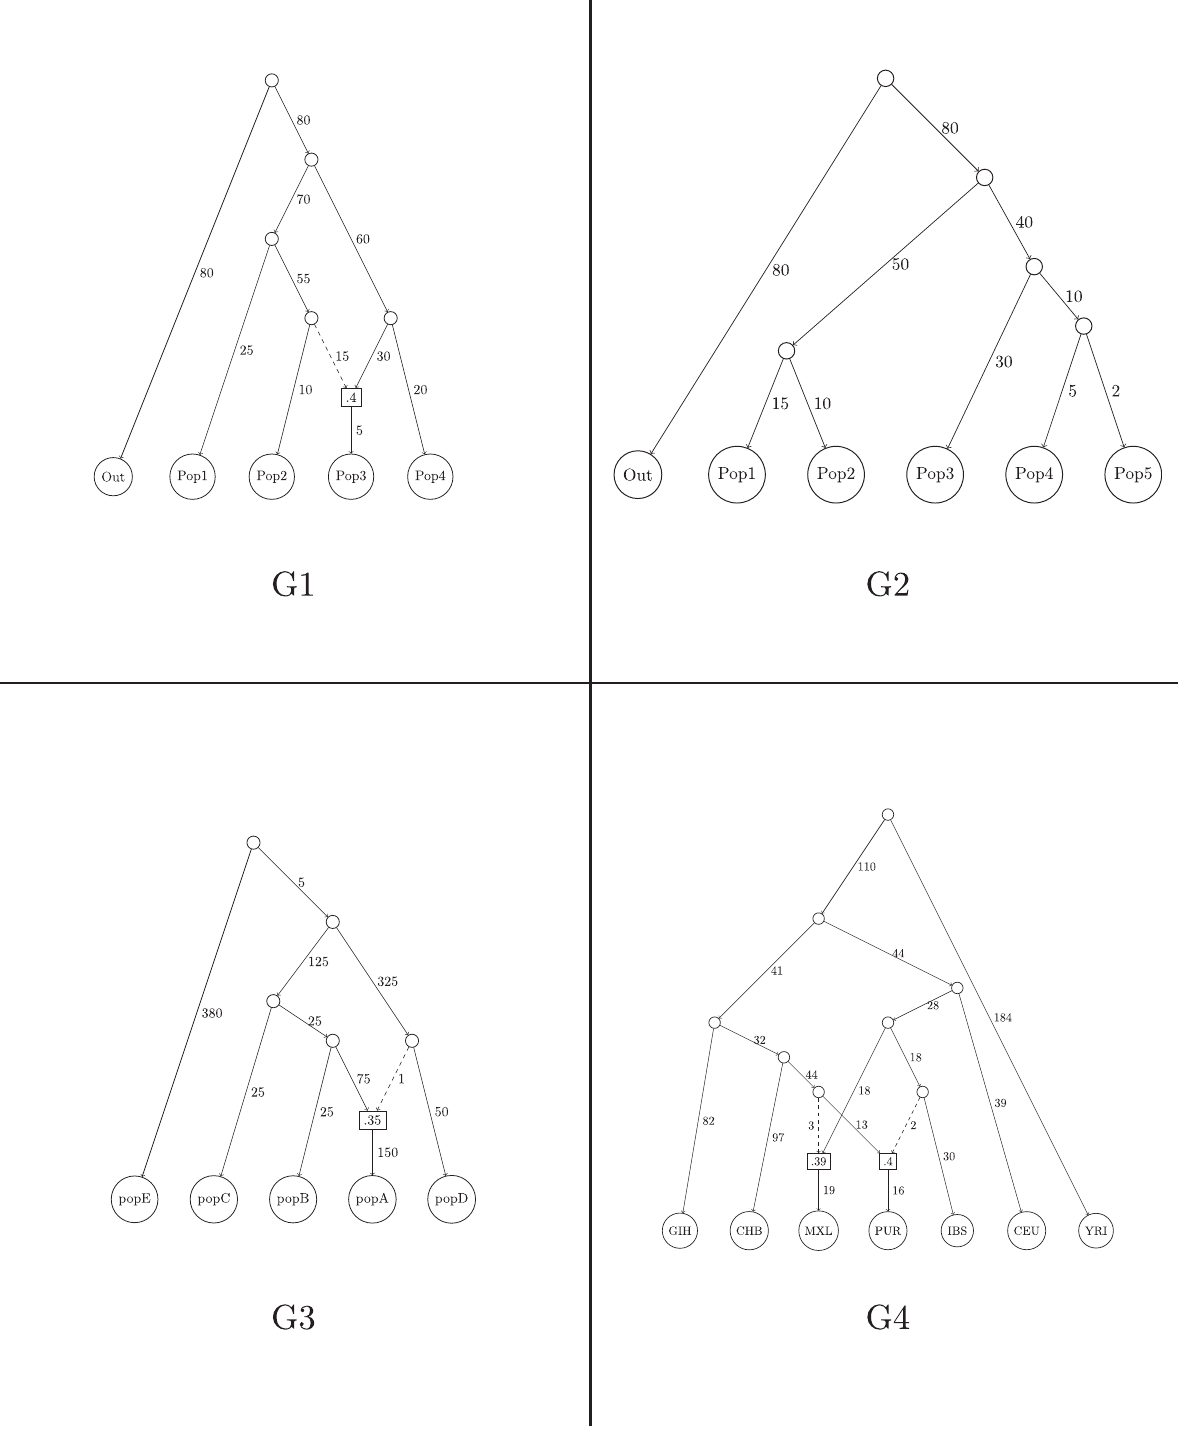
Fig 1. The graphs G1, G2, G3, and G4 used for the comparisons between methods. G1 and G2 are not based on any real dataset, but the branch lengths are chosen to have human-like values. Out was used as the outgroup for both graphs. G3 is based on M1 from Molloy et al . (2021), the graph that motivated the development of the MLNO approach of OrientAGraph. We have changed some of the branch lengths. popE was used as the outgroup. G4 is based on Model M7 from Fig 3 of Molloy et al . (2021), which is in turn based on Fig 7a from Wu (2020) [19]. The populations ITU, JPT, and ASW have been removed. The YRI population was used as the outgroup. For all graphs, as in Molloy et al . (2021), branch lengths are not shown to scale and are shown multiplied by 1000. Divergence nodes are shown as circles. Admixture nodes are shown as rectangles. The fractions inside the admixture nodes denote the contribution from the population represented by the dashed